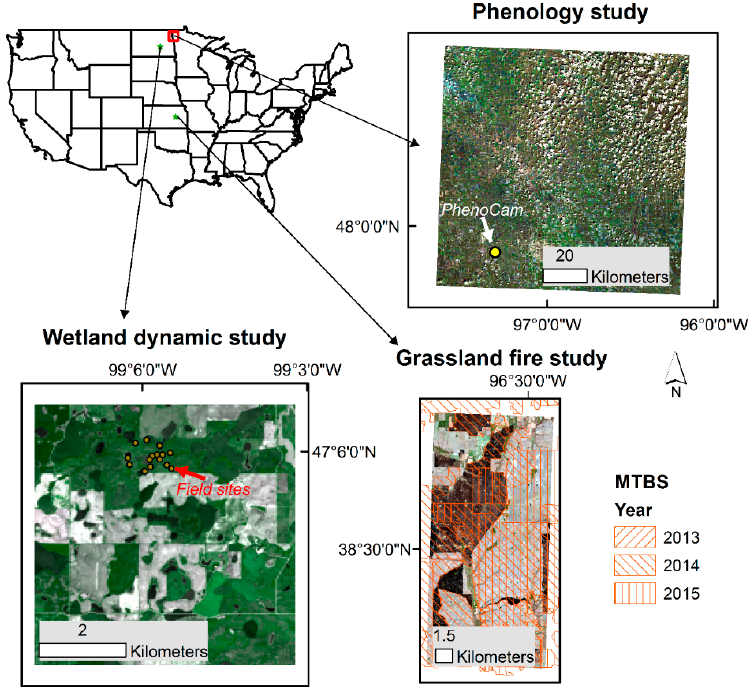
Figure 1. Location of the three study areas. The background images for phenology, grassland fire, and wetland dynamics are true-color composites from Landsat-8 on 27 July, 8 April, and 20 June 2016, respectively.The dashed lines in the grassland fire study area are burned areas from 2013 to 2015, as indicated by the Monitoring Trends in Burn Severity (MTBS) product.